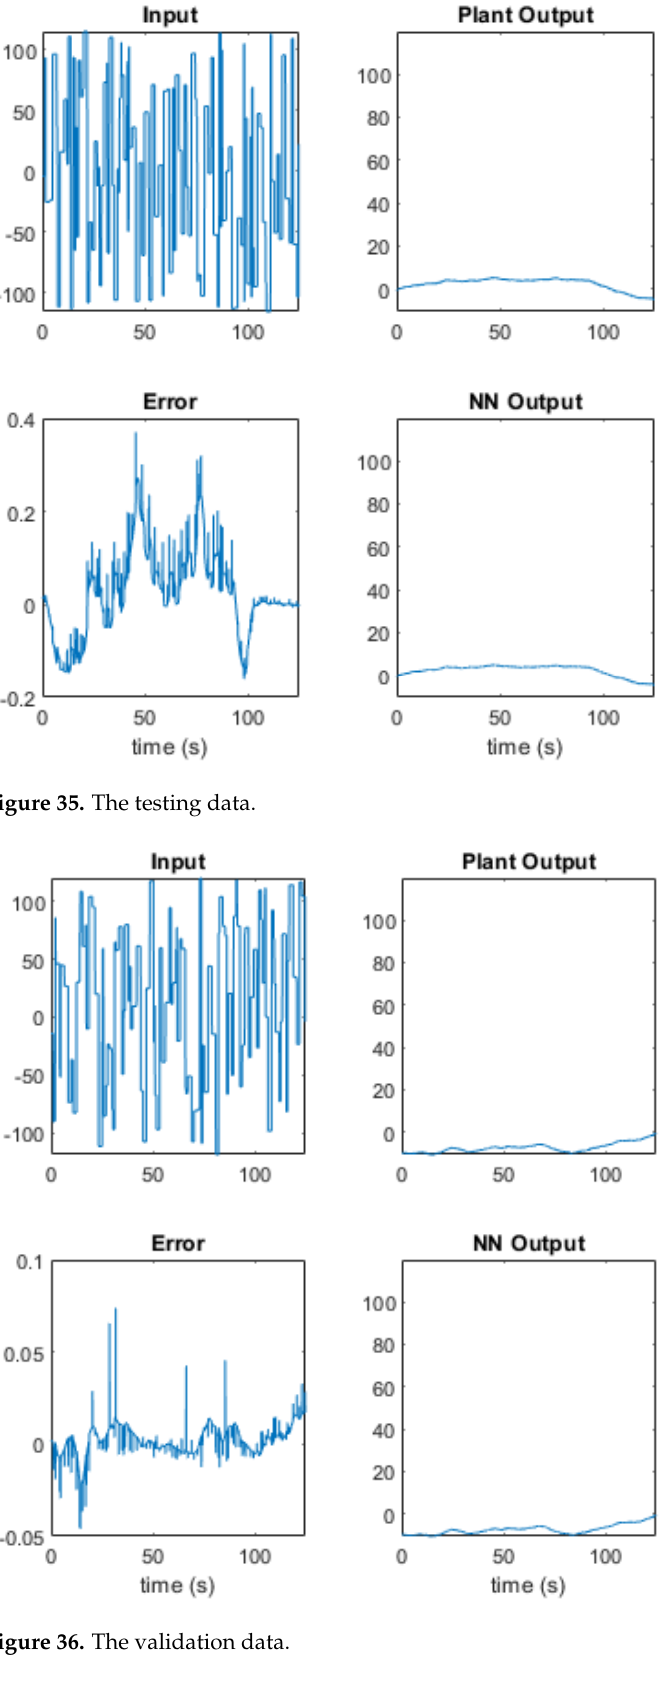
Figure 36. The validation data.